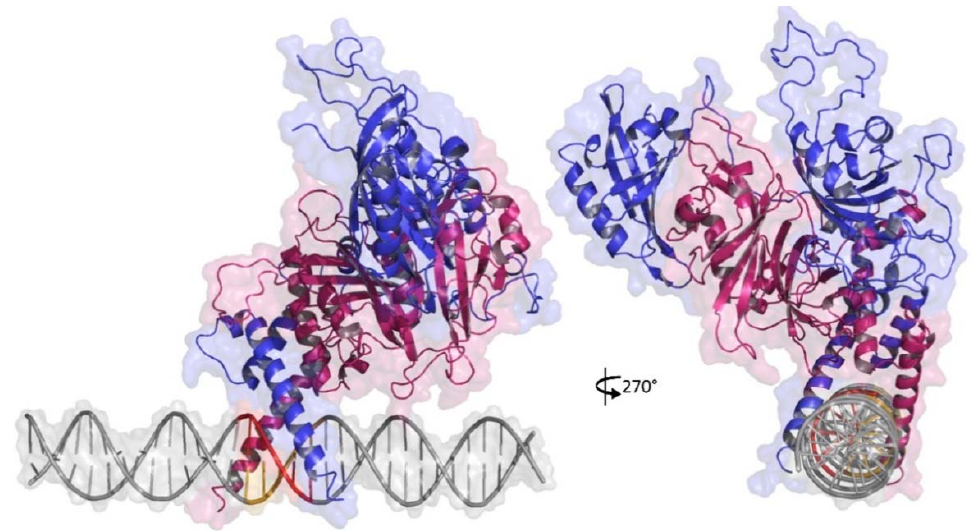
Figure 2. 3D representation of similar docking pose obtained to HIF1-HRE molecular complexes generated by HADDOCK server. HRE in DNA double helix is highlight in red. Chain A is highlighted in reference to β subunit (ARNT) in blue and chain B is highlighted in reference to α subunit (HIF1a) in pink. Note: Author's own image.